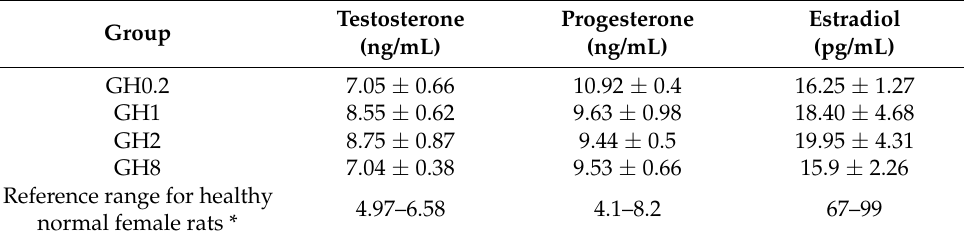
Table 5. Summary of the serum testosterone, progesterone and estradiol levels amongst groups receiving Gelam honey (GH).